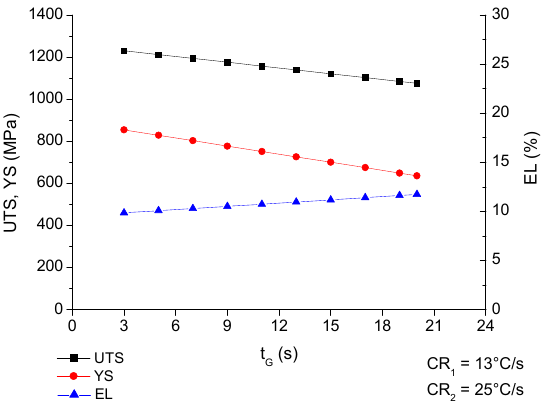
Figure 8. Effect of interruption of cooling ( t G ) on the mechanical properties of DP steel. Calculations with statistical models.